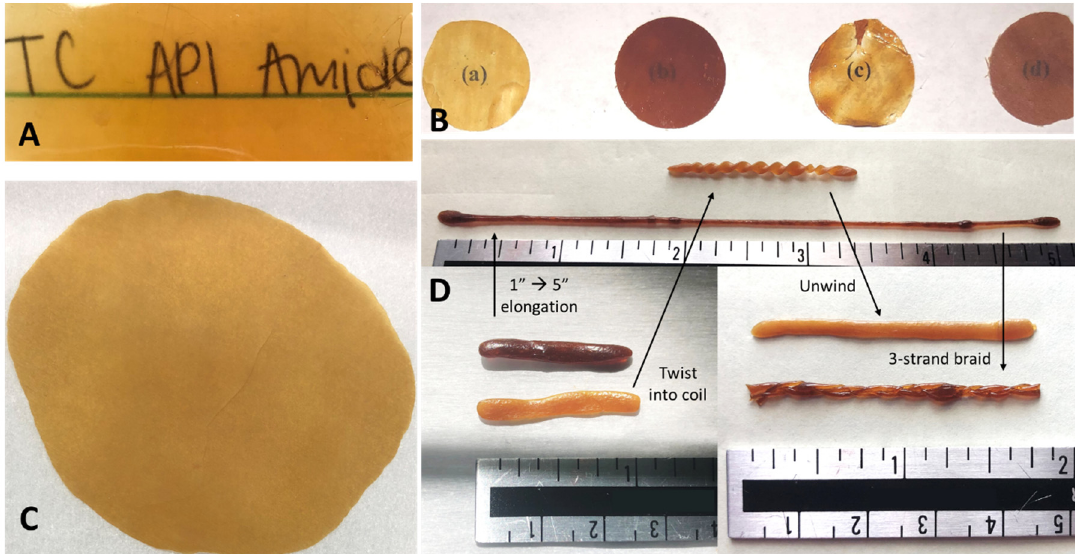
Figure 5. Images of PAA and PAI ionenes. ( A ) neat [TC API Amide][Tf 2 N] forms a transparent film from solvent casting; ( B ) other PAA and PAI ionenes {a: TC I4A Amide, b: PMDA API Amide, c: 6FDA API Amide, d: 6FDA I4A Amide} showing transparency as thin films; ( C ) [TC API Amide][Tf 2 N] as an opaque film melt-pressed at 120 °C; ( D ) [TC I4A Amide][Tf 2 N] and [6FDA API Amide][Tf 2 N] composite fibers, elongated to show elasticity and amenability to contortion (demonstrated through coiling or braiding).